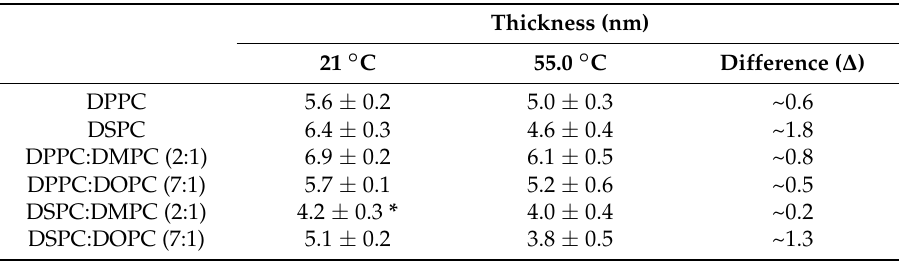
Table 2. Total thickness bilayer variation for each phospholipid